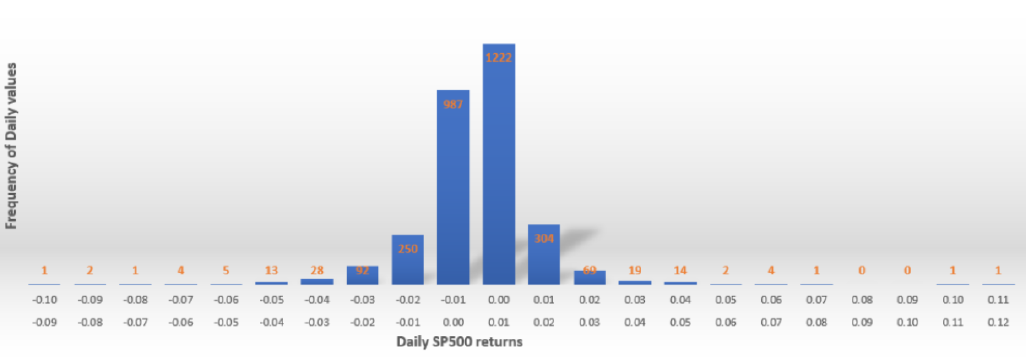
Figure 3. Distribution of S&P500 returns from June 2007 to June 2019.